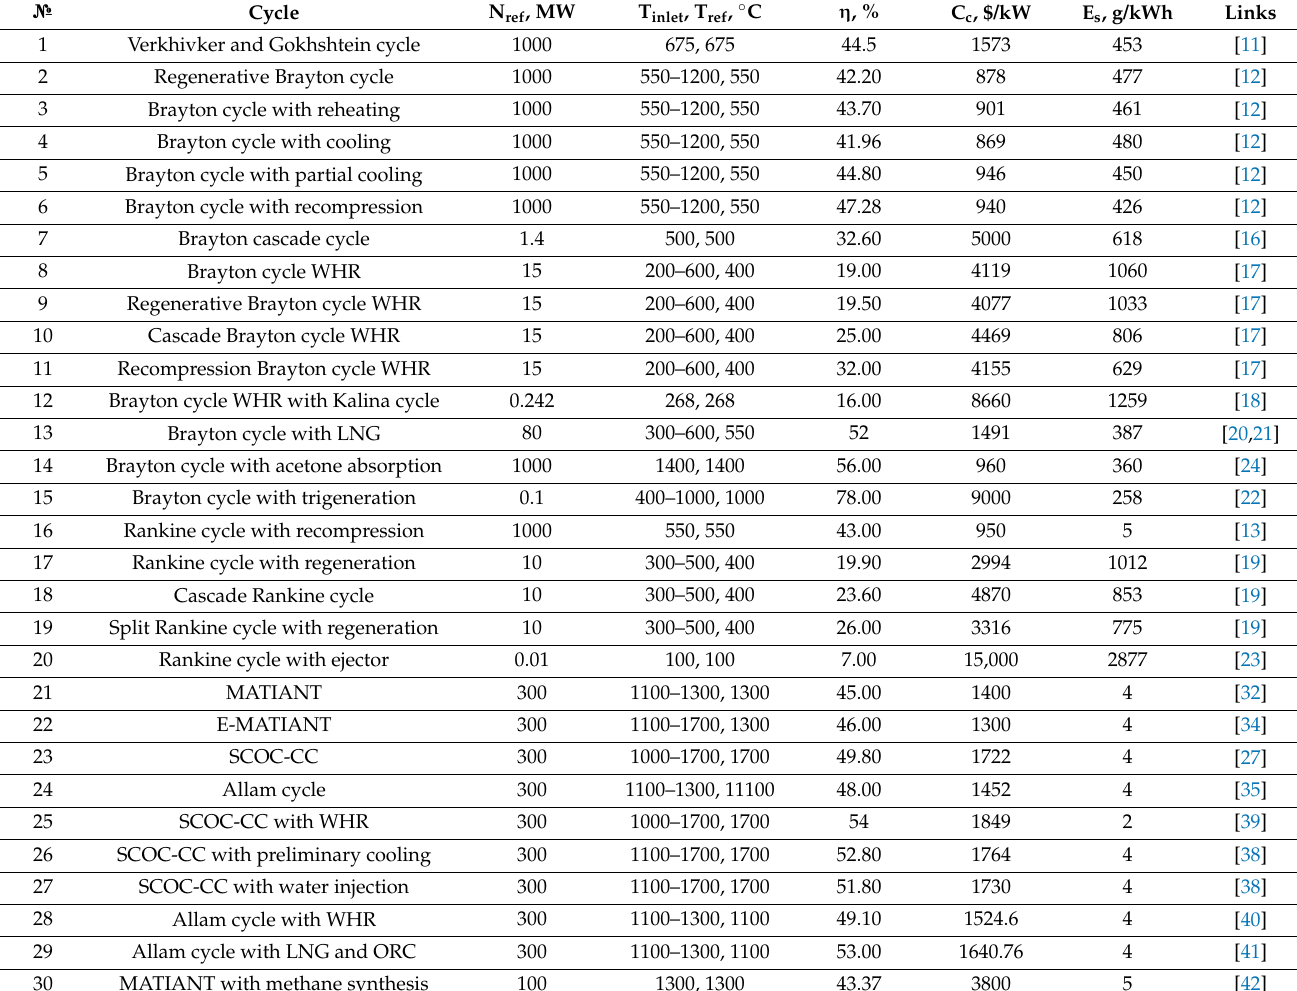
Table 2. Supercritical CO 2 power